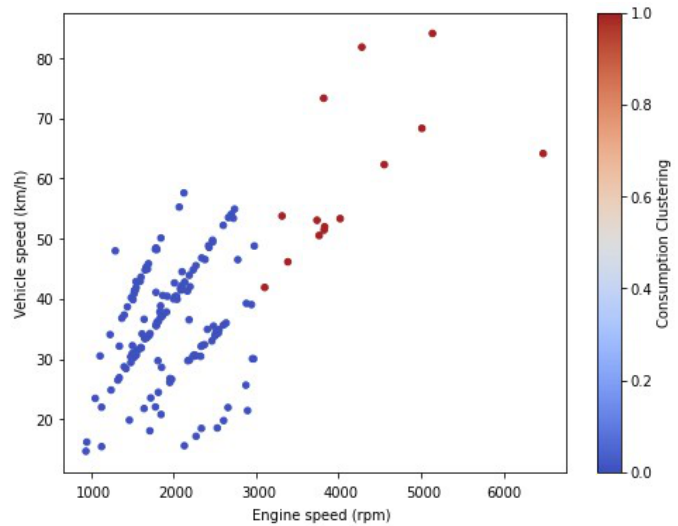
Figure 11. Consumption Clustering: vehicle speed vs. engine speed.